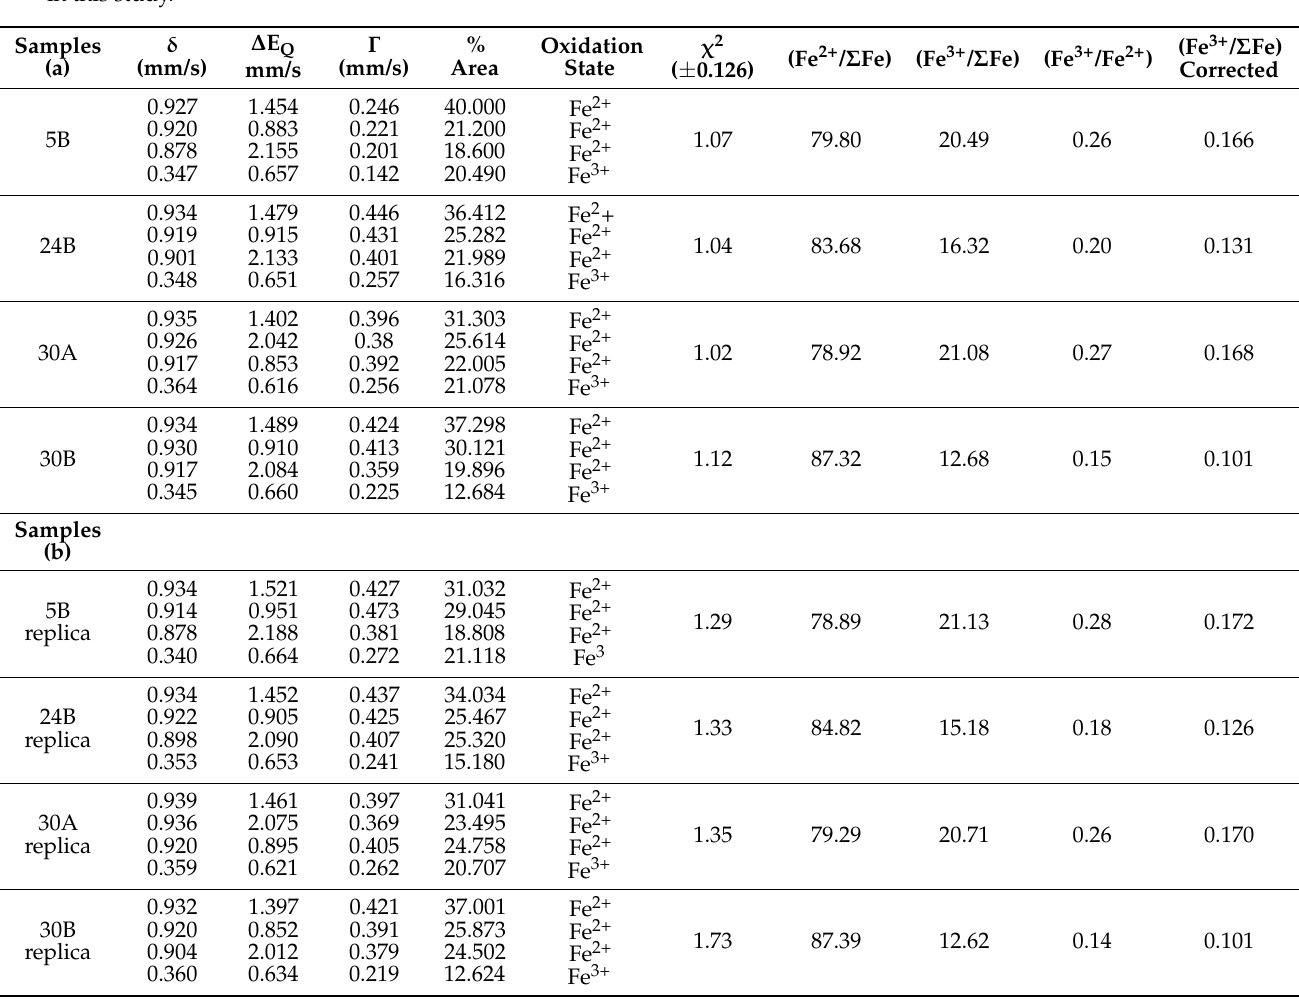
Table 2. Mössbauer parameters and corrected (Fe 3+ / Σ Fe) ratios obtained from ( a ) measurements of samples and ( b ) repeated measurements of three replica samples, respectively. δ = centroid shift (mm/s), ∆ EQ = quadrupole splitting (mm/s), Γ = full width at half-maximum (mm/s). The averages of (Fe 3+ / ∑ Fe) ratios for the samples and their respective replicas are reported in this